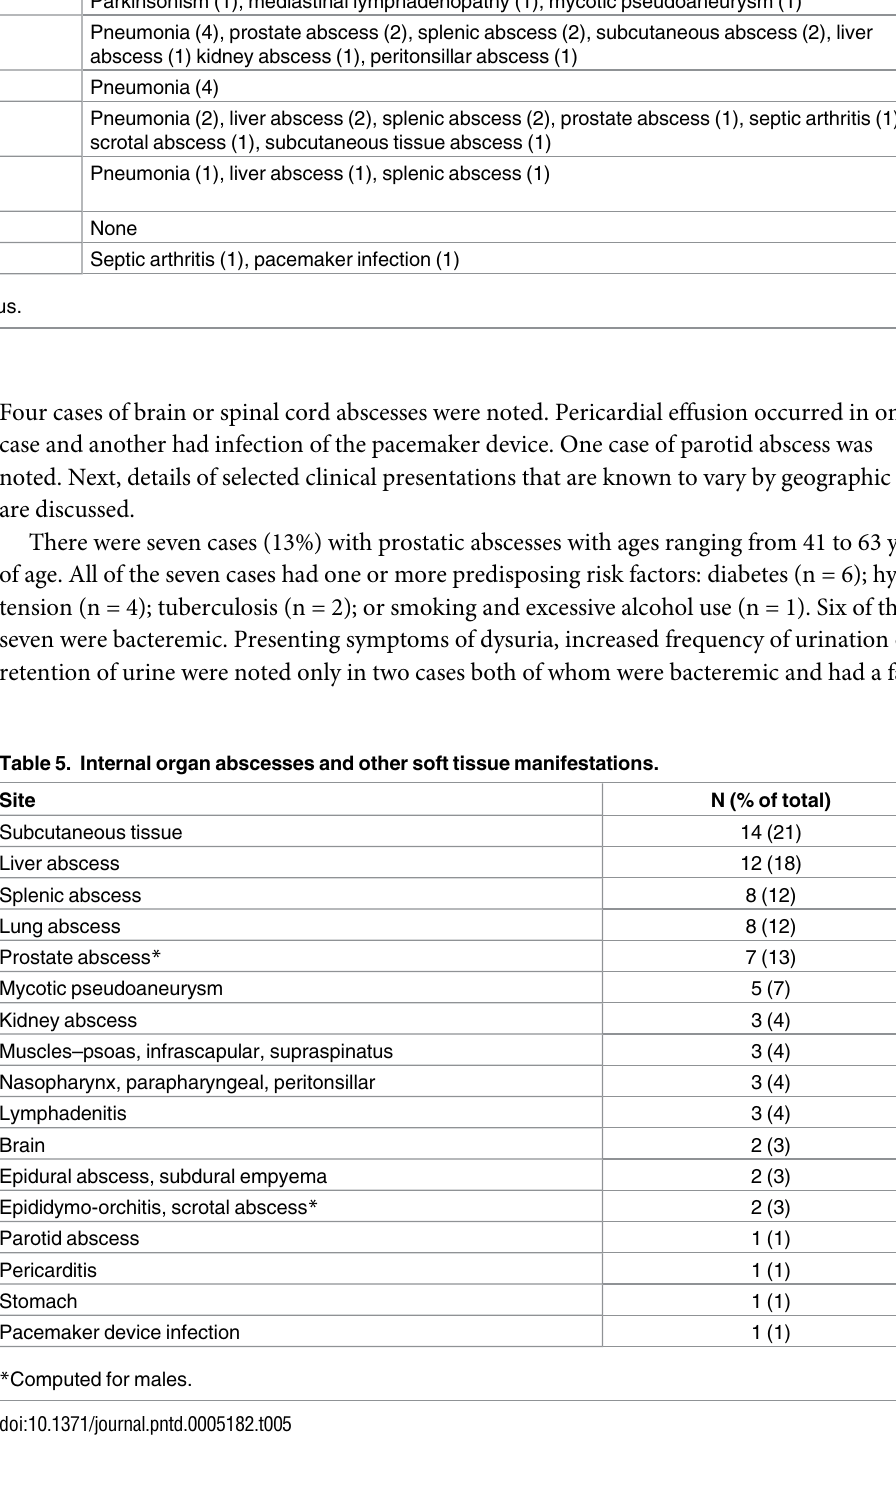
Table 4. Secondary clinical foci for primary diagnostic groups.